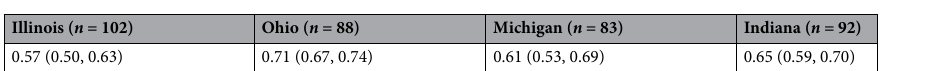
Table 2. Median (inter quartile range) of the proportion of variance explained by the first fPCA by state. n represents the number of counties in each